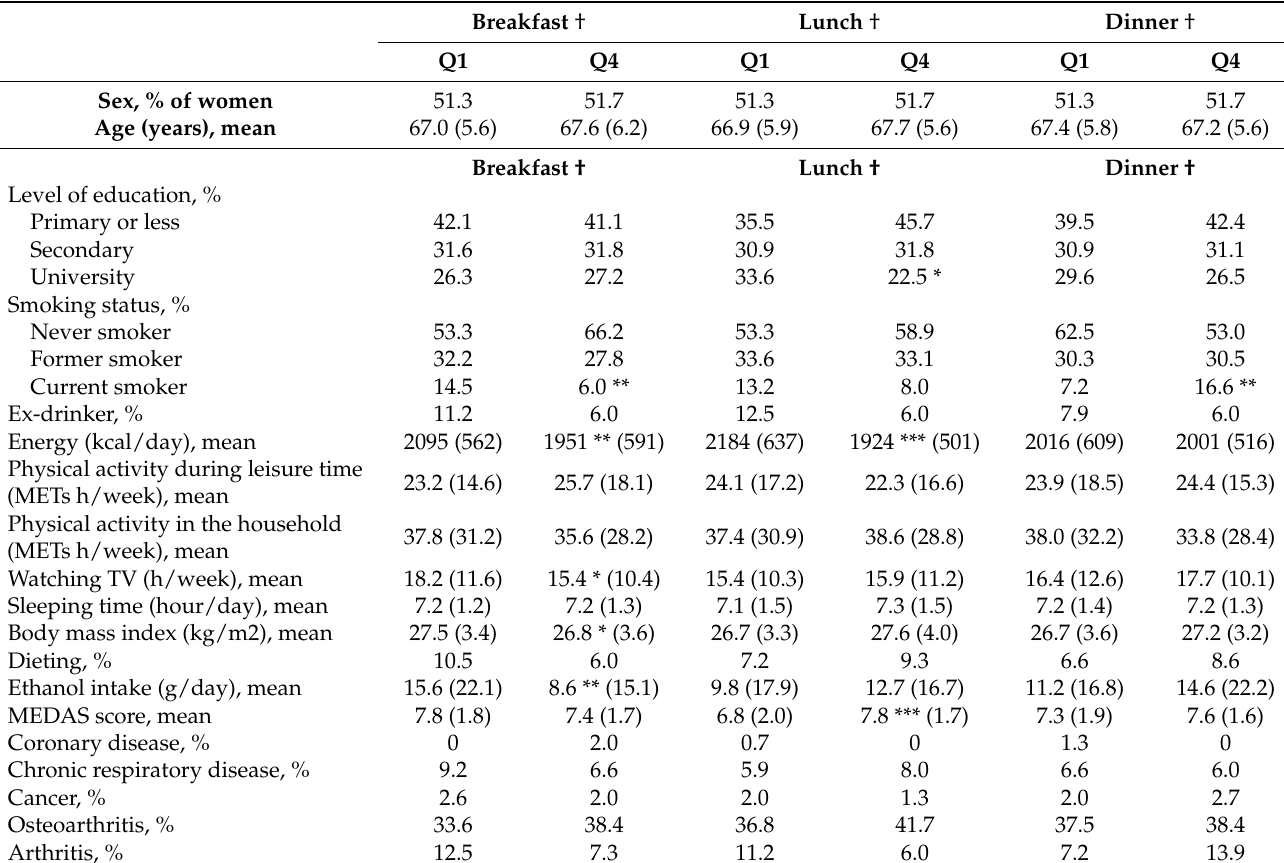
Table 2. Baseline characteristics of the participants in the Seniors-ENRICA-1 cohort study according to sex-specific quartiles of the percentage of energy intake at breakfast, lunch, and dinner. N =